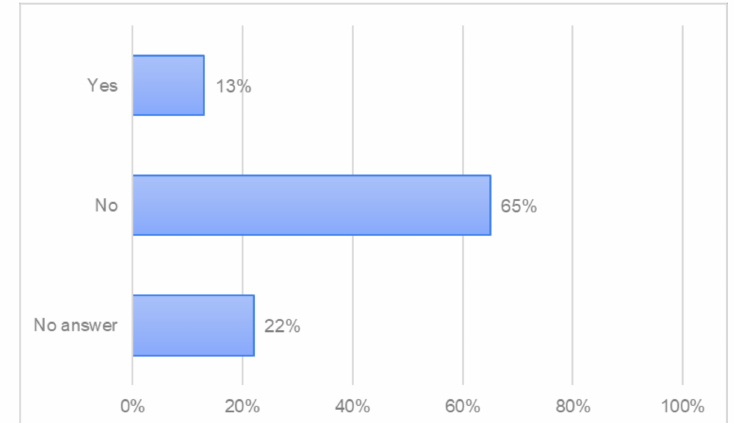
Figure 6. Summary of injuries to colleagues.